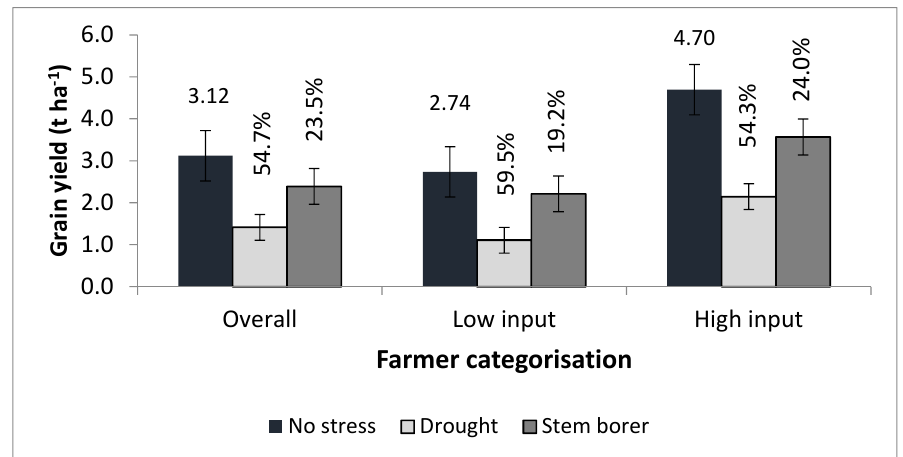
Figure 3. Yield based on farmer categorisation under different conditions for conventional maize varieties. The relative values in % indicate the relative yield loss in comparison with the non-stress yield. Based on their fertilizer use, 83 farmers were categorized as high input farmers and 367 as low input farmers.